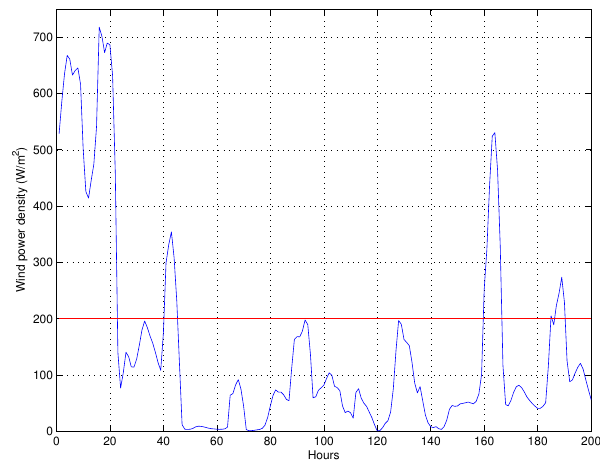
Fig. 1. Illustrative WPD profile showing the fluctuations in